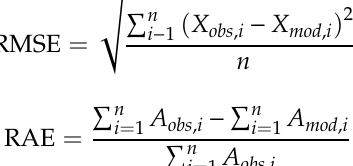
Figure 2. Chl a estimation workflow using S2, L8 and WV3 images.